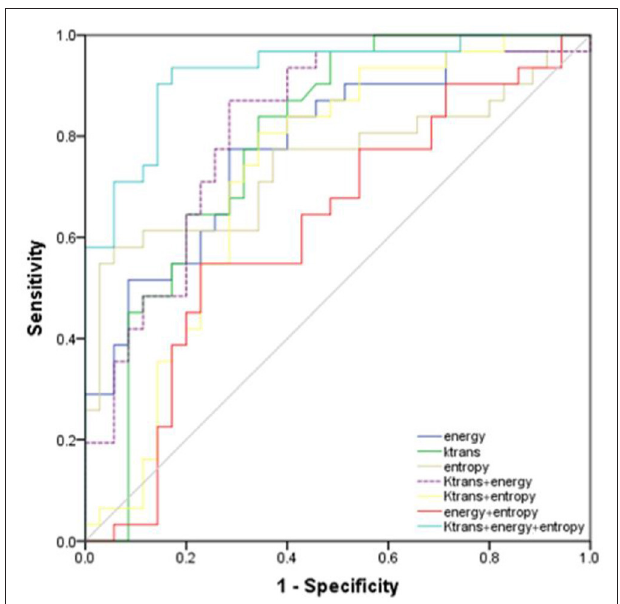
FIGURE 3 | Receiver operating characteristic curves of the energy, K trans , entropy, combination of K trans and energy, combination of K trans and entropy, combination of energy and entropy, combination of K trans , energy, and entropy for diagnosis of invasion and non-invasion of cervical cancer.